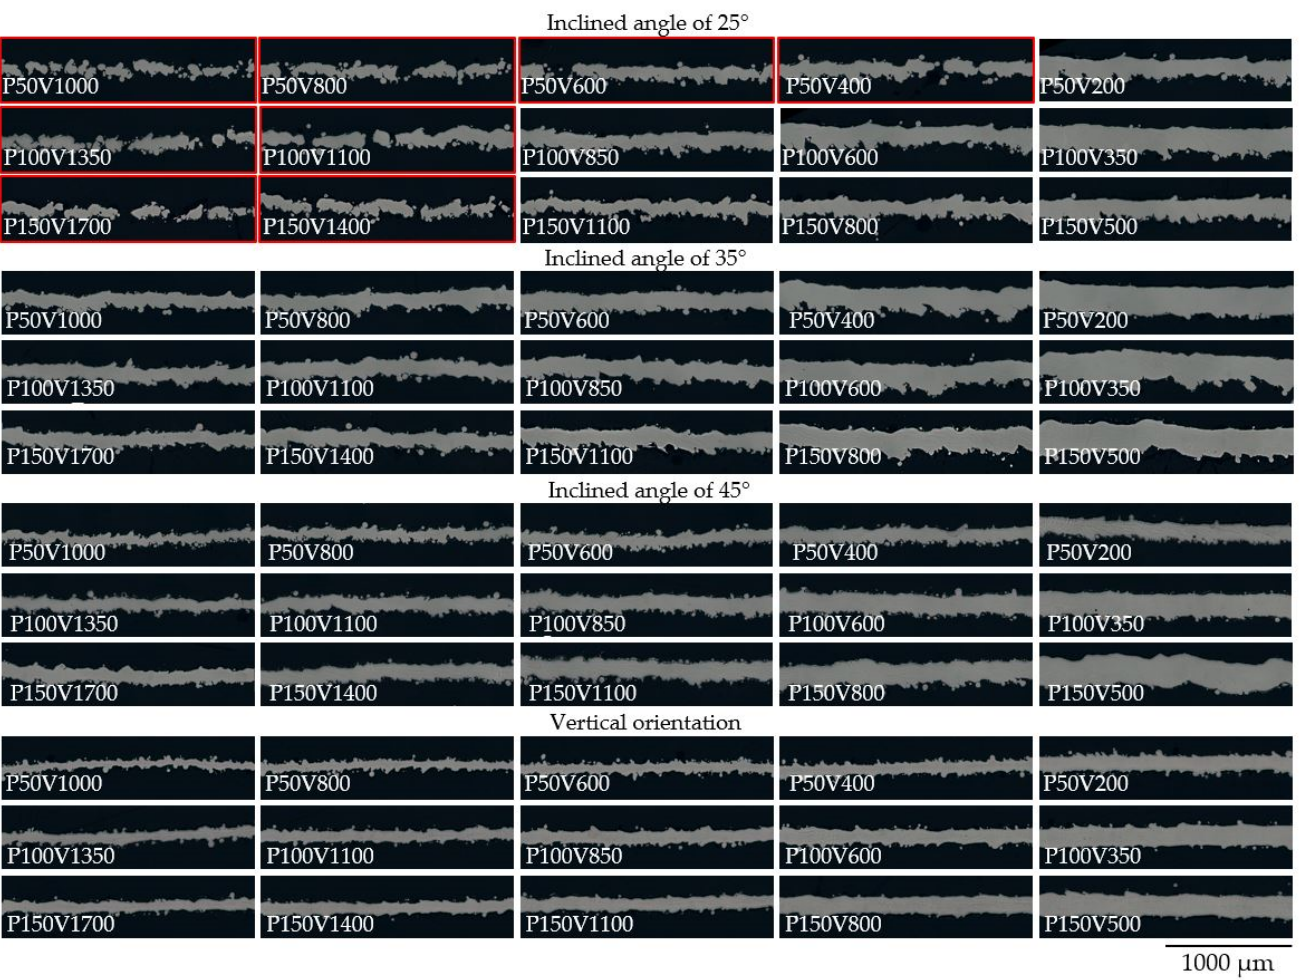
Figure 5. OM of cross-sections for single track based thin walls. Samples with lack of fusion defect are highlighted with red.